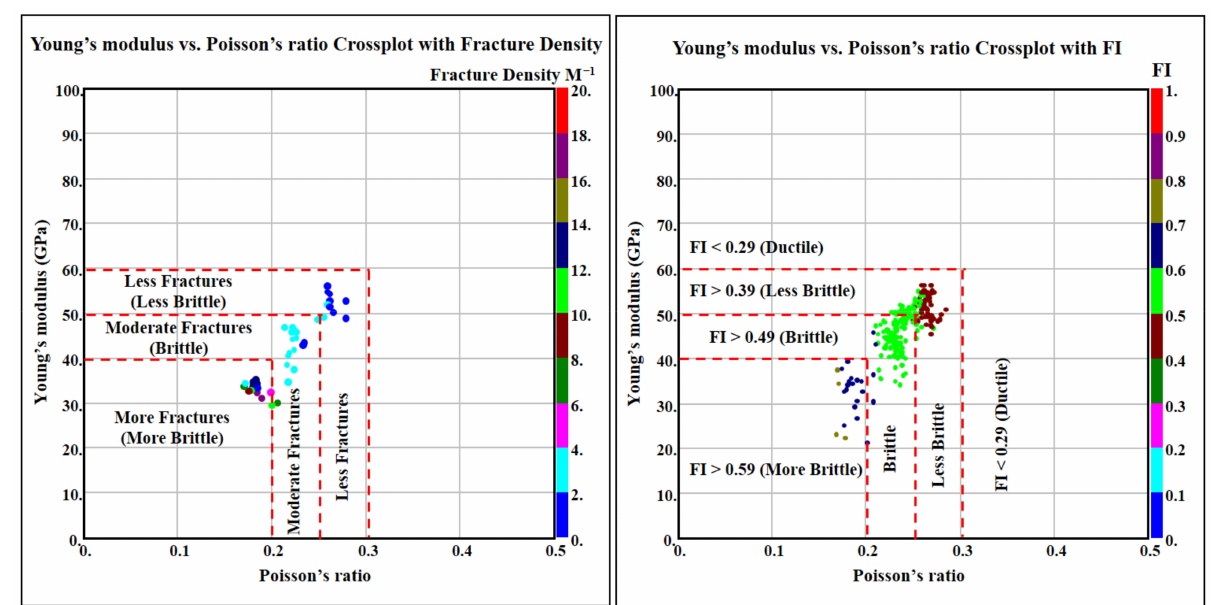
Figure 6. Classification of fracability index in low permeability